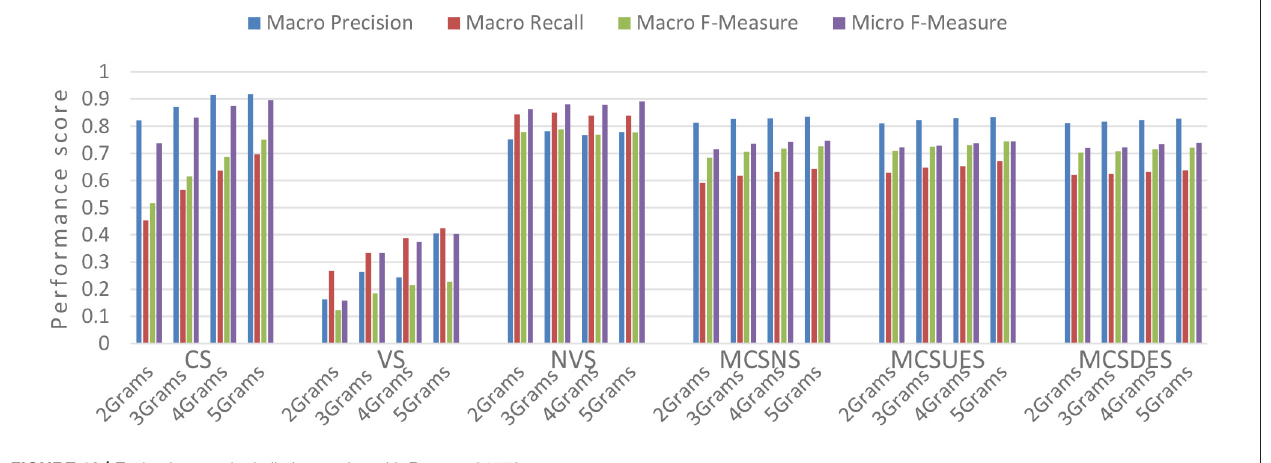
FIGURE 10 | Evaluating graph similarity metrics with Reuters-21578.